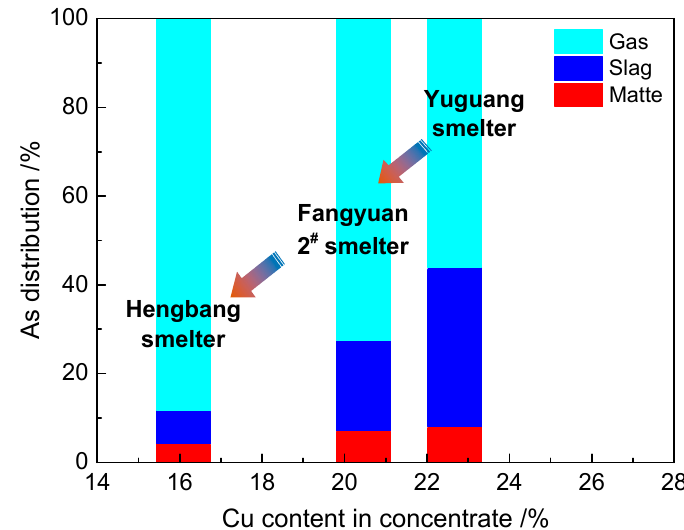
Figure 11. Arsenic distribution in different copper smelters.